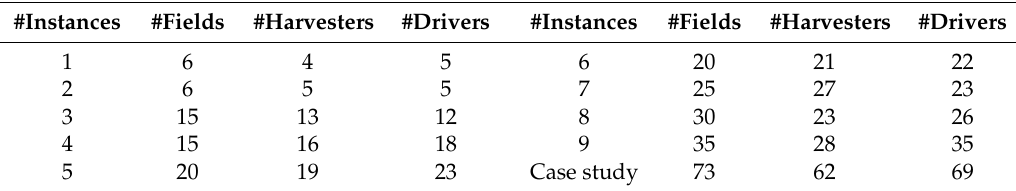
Table 10. Characteristics of test instances and case study.